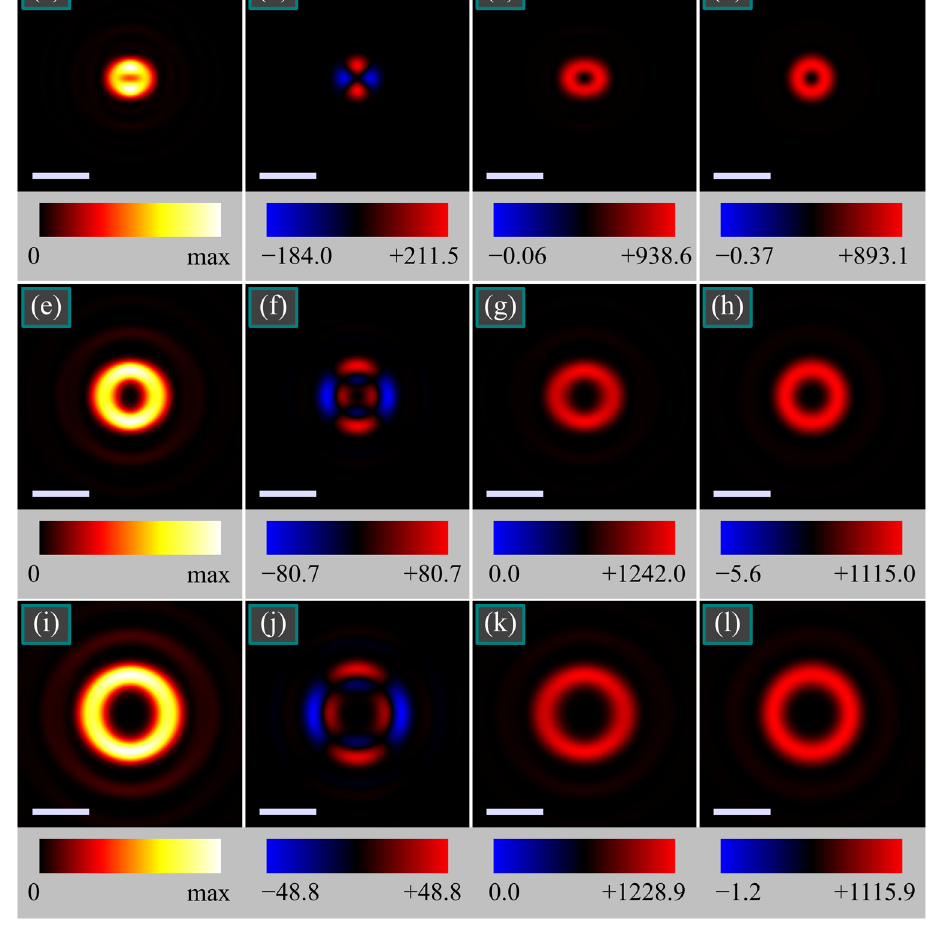
Figure 1. Distributions of the intensity ( a , e , i ), the SAM density ( b , f , j ), the OAM density ( c , g , k ), and the AM density ( d , h , l ) of the beam (1) in a tight focus at n = 1 ( a – d ), n = 3 ( e – h ), and n = 5 ( i – l ) with the following calculation parameters: wavelength λ = 532 nm, focal length f = 10 μ m, numerical aperture NA = 0.95, and size of the computational domain = 4 × 4 μ m 2 . The scale mark in all figures means 1 μ m. The numbers on the color scales below each figure indicate the minimum and maximum values.